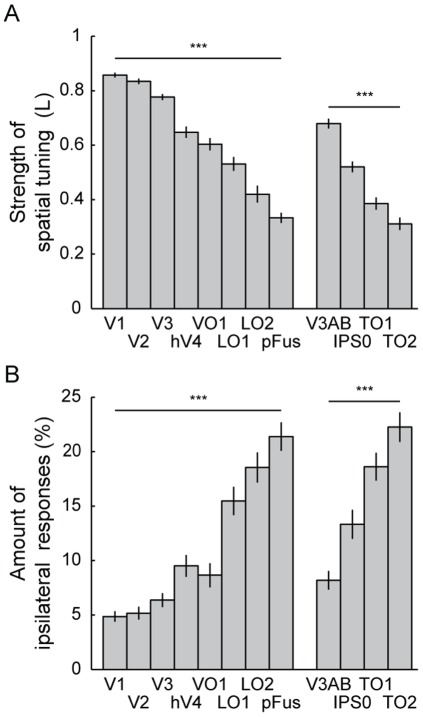
Strength of spatial tuning and amount of ipsilateral responses.A) The mean strength of the spatial tuning in different visual areas was averaged across the 15 subjects. The error bars indicate the standard errors of the means (SEMs) across the subjects. Visual area had a significant effect on the tuning strength (***p<0.001, Page's L test for the trends). B) The mean amount of ipsilateral responses was defined as the sum of responses for stimuli in the ipsilateral visual field divided by the sum of responses for all of the stimuli. Negative responses were ignored. The results were averaged across the 15 subjects and the error bars indicate the SEMs across the subjects. Visual area had a significant effect on the amount of ipsilateral responses (***p<0.001, Page's L test for the trends).